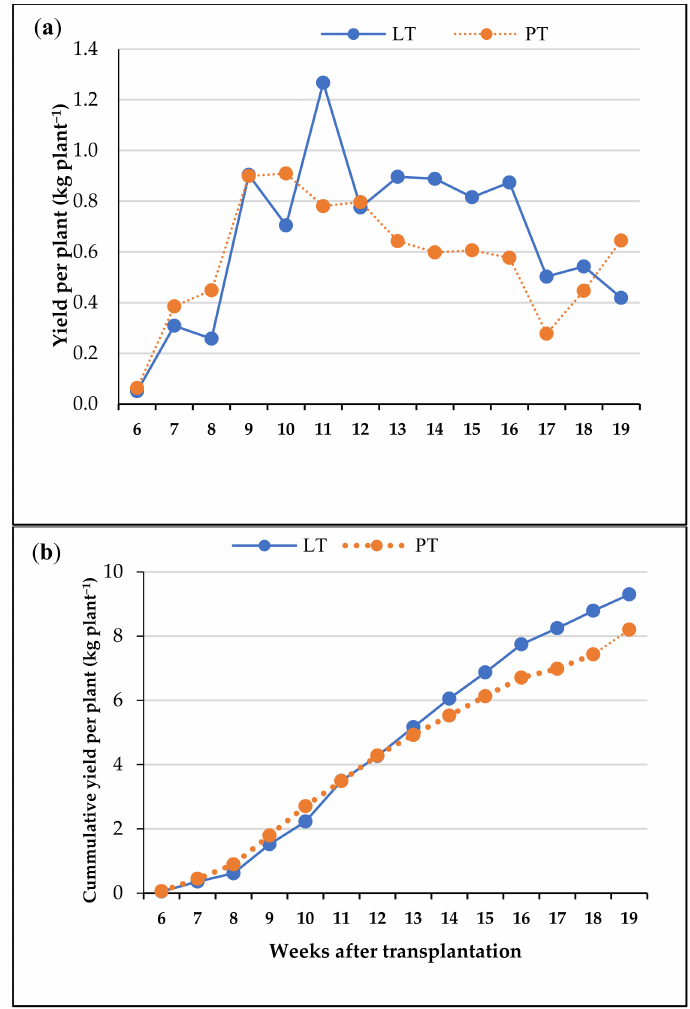
Figure 9. Plant yield variation ( a ) and plant cumulative production of fruits ( b ) during the harvesting period.